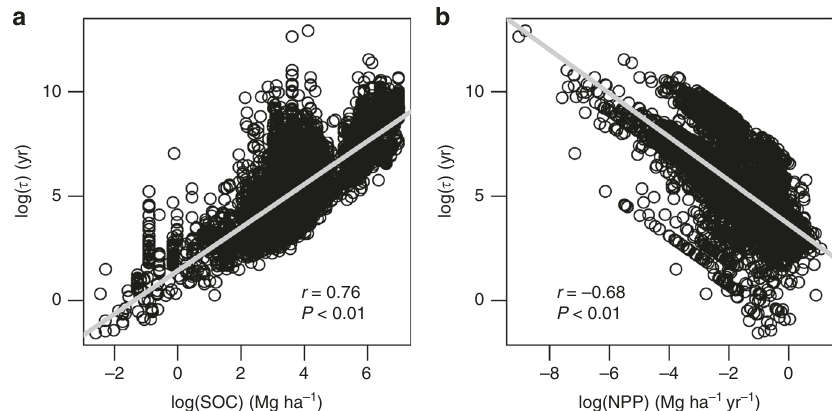
Fig. 2 Correlation of turnover times with carbon stock and productivity. a , b The relationship of subsoil (0.3 – 1 m soil layer) organic carbon turnover times with soil organic carbon stock in that layer and net primary productivity allocated to that layer, respectively. This relationship is assessed based on data from 10,000 randomly sampled pixels across the globe. All data were natural log-transformed